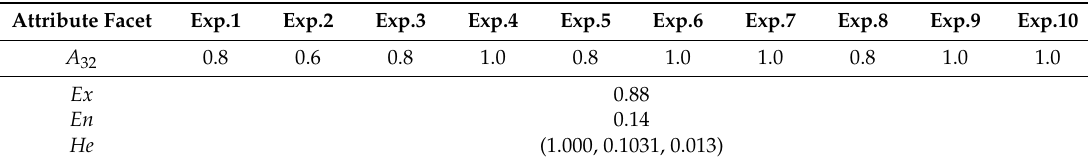
Table 3. Numerical characteristics of attributes facet A 32